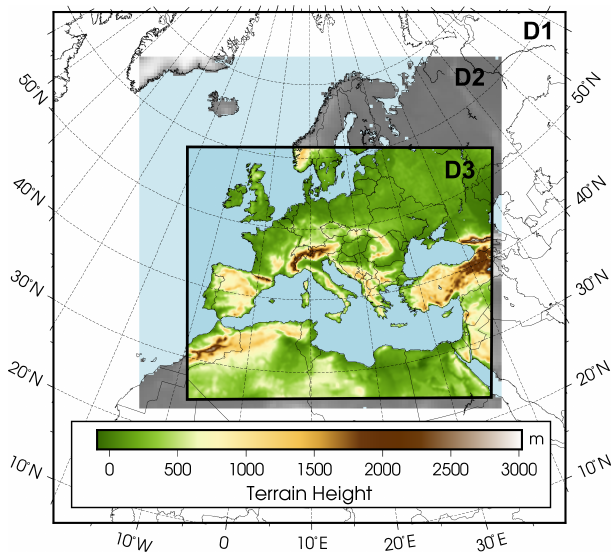
Figure 1. Target (D3) and nested domains (D1 and D2). Adapted from Palacios-Peña et al.